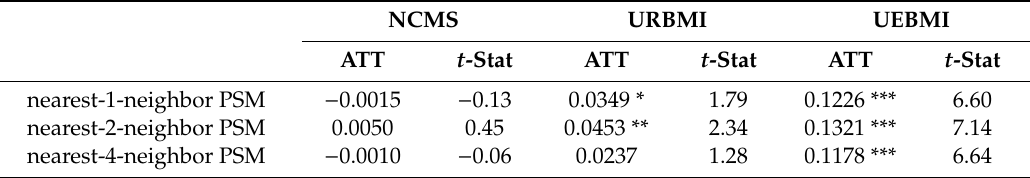
Table 4. Average treatment e ff ect on the treated (ATT) of the health insurance schemes on monthly net income. NCMS URBMI UEBMI ATT t -Stat ATT t -Stat ATT t -Stat nearest-1-neighbor PSM − 0.0015 − 0.13 0.0349 * 1.79 0.1226 *** 6.60 nearest-2-neighbor PSM 0.0050 0.45 0.0453 ** 2.34 0.1321 *** 7.14 nearest-4-neighbor